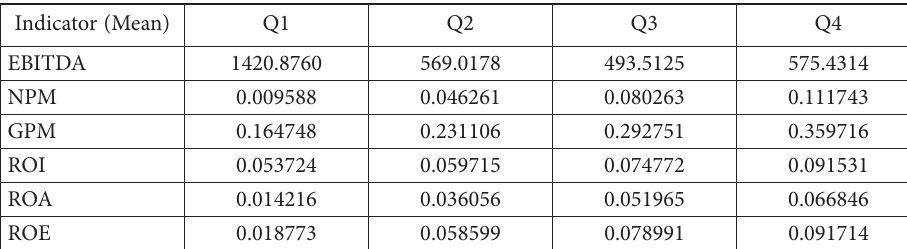
Table 5. Descriptive statistics of the Kruskal-Wallis’